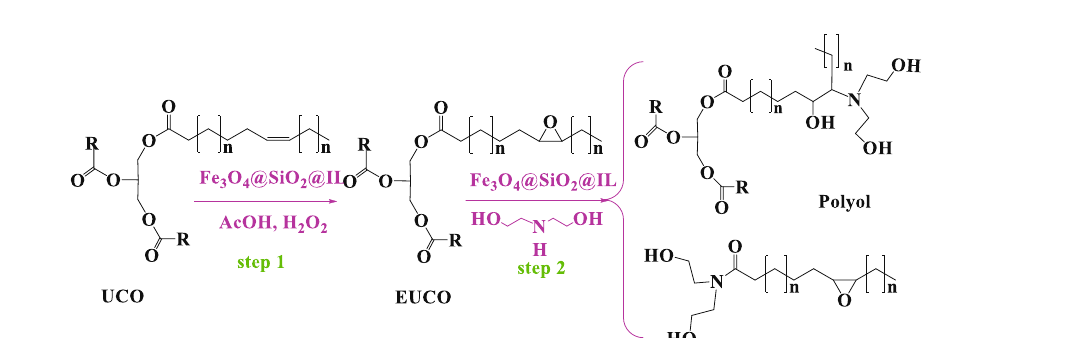
Figure 1: The catalyst synthesis steps.